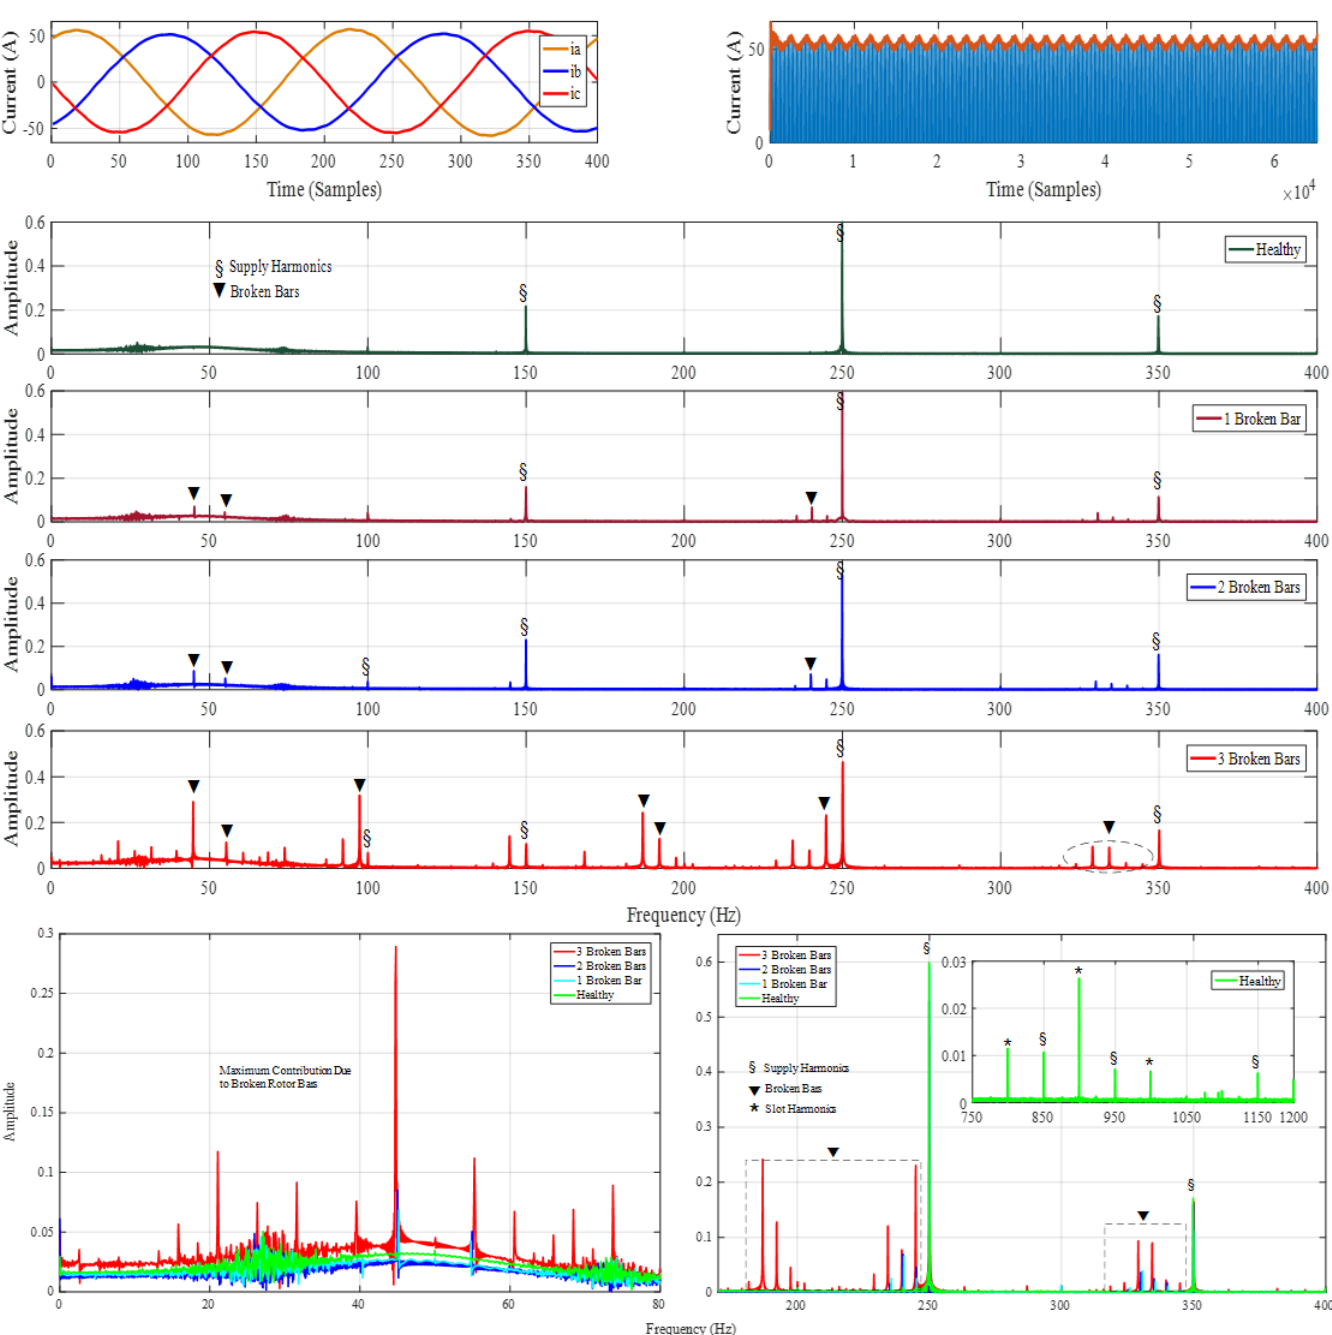
Fig. 7. Experimental results: three phase current – top left, per phase current and its envelope for three broken bars – top right, frequency spectrum for healthly, one, two, and three broken bars cases from top down; zoomed comparison of harmonics for healthy and faulty motors at the